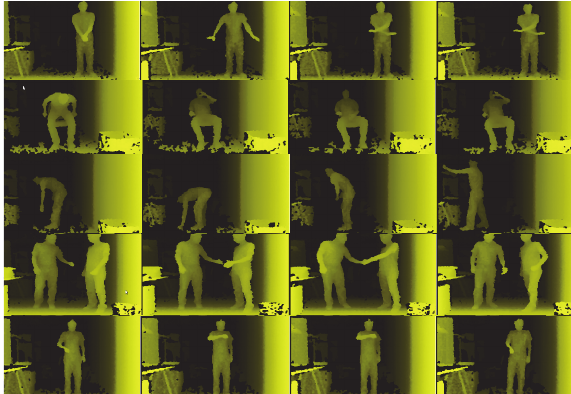
Figure 4: Screenshot images at four different positions during the dead ball, sit and drink, pick something from ground, handshake, and check watch